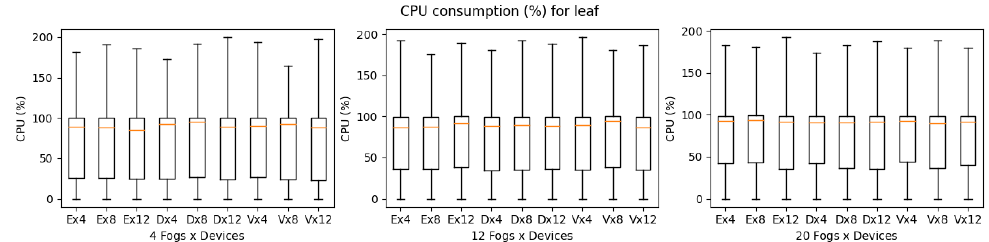
Figure 14. CPU consumption for LEAF during simulation (E: eHealth; D: DCNS; V: VRGame).